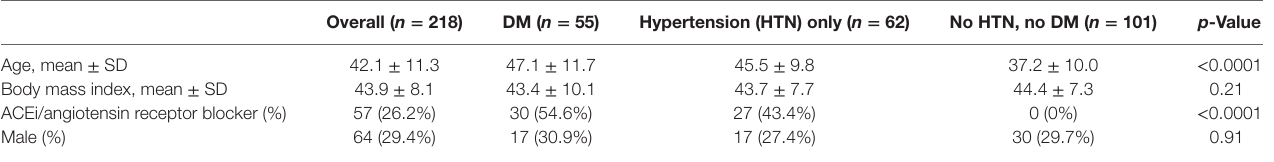
Table 1 | Baseline